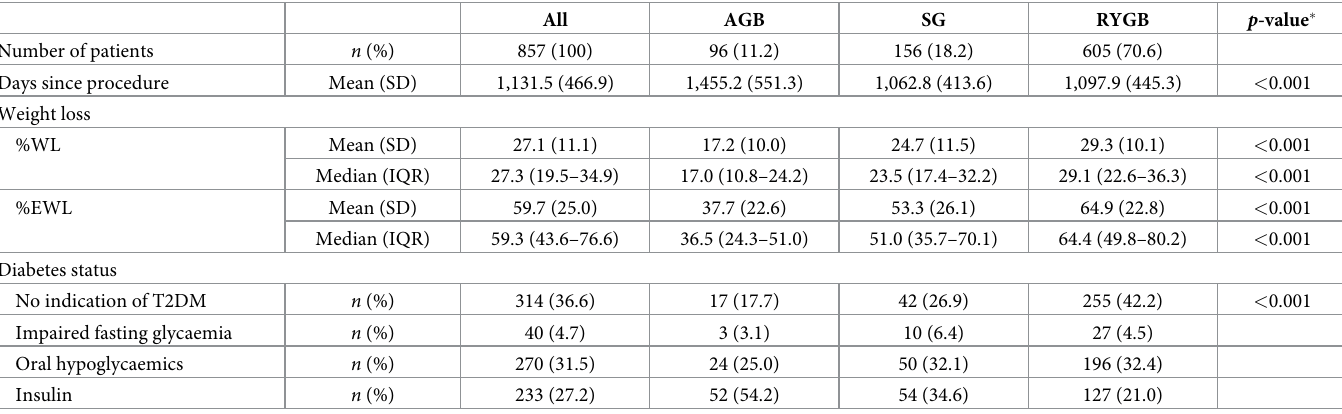
Table 3. Outcomes for surgical patients at final follow-up by procedure ( n = 857). All AGB SG RYGB p -value